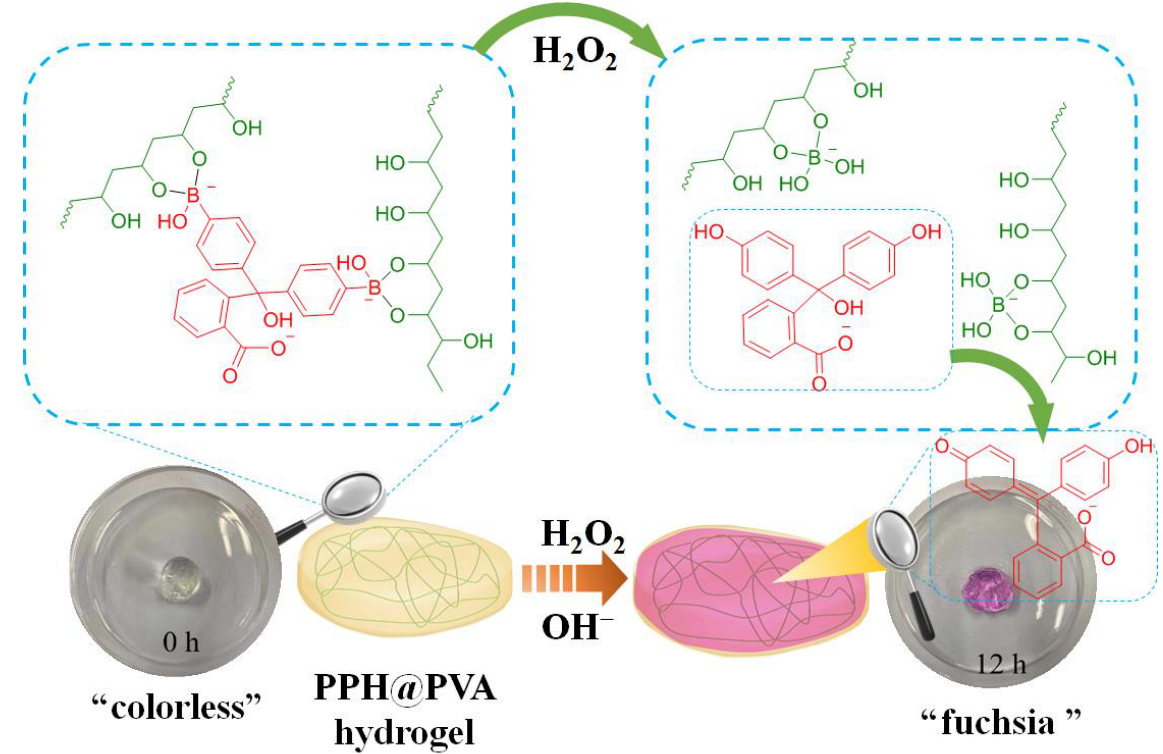
Figure 4. Colorimetric H 2 O 2 -responsive mechanism of phenolphthalein-crosslinked hydrogel (PPH@PVA) reported by our group (Reprinted/adapted with permission from Ref. [52]. Copyright year: 2022, copyright owner’s name: Hailei Zhang)